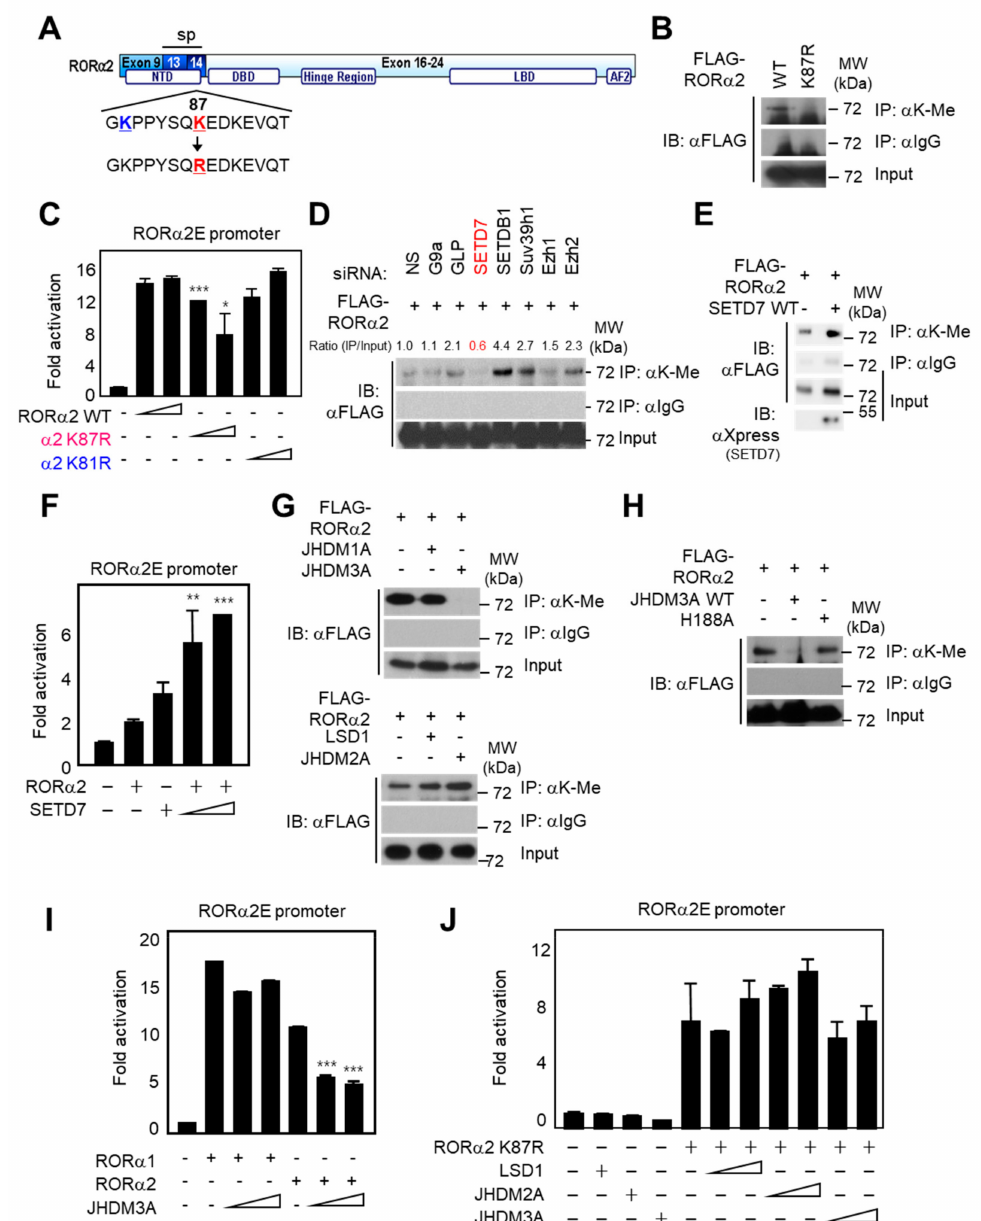
Figure 3. Lysine 87 of ROR α 2 is crucial for methylation by SETD7. ( A ) Schematic representation of the NTD of ROR α 2. The position of the K87R mutation is highlighted in red, and control mutation lysine 81 site is highlighted in blue. ( B ) 293T cells were transfected with FLAG–ROR α 2 WT or K87R mutant and cell lysates were immunoprecipitated with anti-lysine (K) methyl antibody, followed by immunoblotting analysis against anti-FLAG antibody indicating methylated ROR α 2. ( C ) Introduction of ROR α 2 K87R mutant failed to increase the transcriptional activation of the ROR α 2E luciferase reporter. Data are represented as means ± SD for three independent experiments. Statistical significance was calculated by a two-tailed, unpaired t -test (* p < 0.05, ** p < 0.01, *** p < 0.001). ( D ) ROR α 2 methylation was detected after co-transfection with small interfering RNAs (siRNAs) of each methyltransferase and revealed that knockdown of SETD7 reduced methylated levels of ROR α 2. ( E ) Hismax-SETD7 was transfected with FLAG–ROR α 2, and, after immunoprecipitation with anti-lysine antibody, the methylation level of ROR α 2 was detected by anti-FLAG antibody. ( F ) Introduction of SETD7 increased the